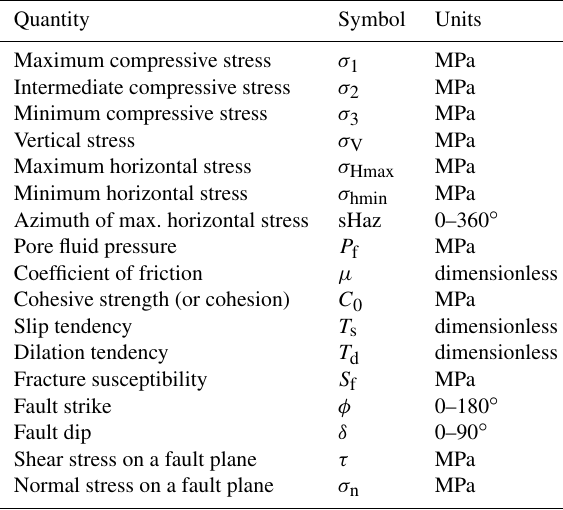
Table 1. List of terms and symbols used in this paper, with units where